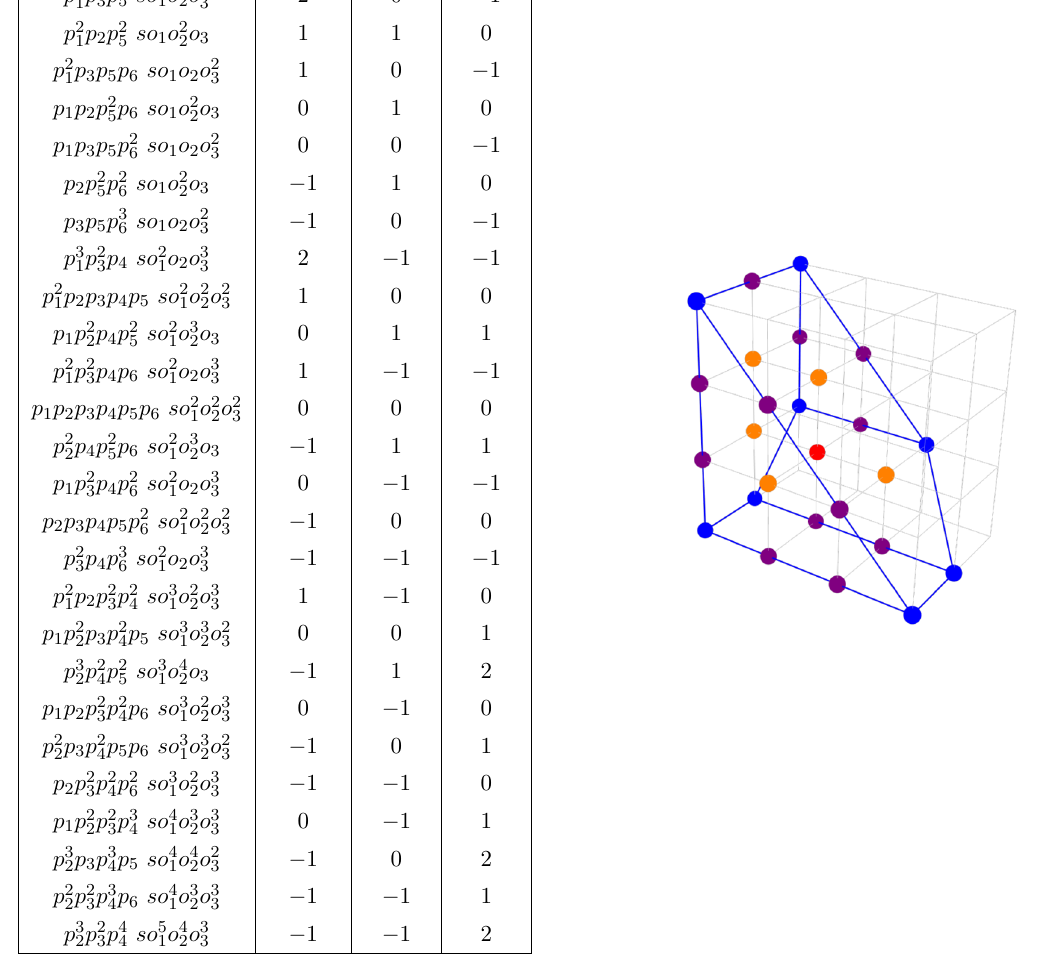
Table 28 . The generators and lattice of generators of the mesonic moduli space of Model 7 in terms of brick matchings with the corresponding flavor